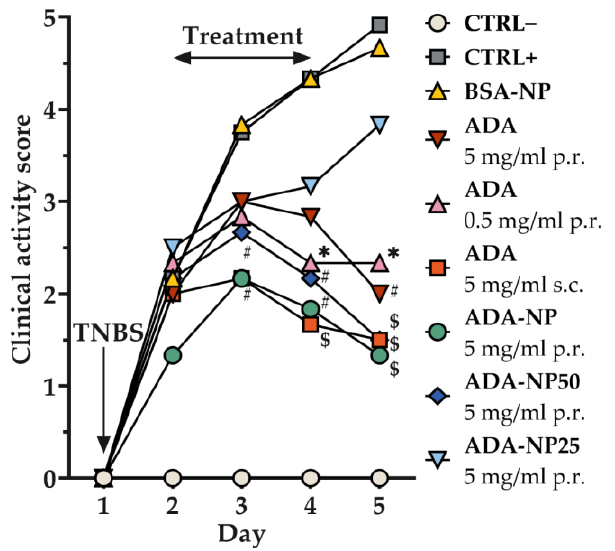
Figure 7. Therapeutic efficacy of adalimumab (ADA) treatment on clinical signs of colitis expressed as the clinical activity score, a composite measure of weight loss, stool consistency and rectal bleeding. Colitis was induced by rectal administration of TNBS (90 mg/kg body weight) and the mice were treated for 3 consecutive days. Data are shown as mean ± SD ( n = 6). Error bars are not shown for clarity reasons. Statistical significance was assessed by one-way ANOVA followed by Tukey’s multiple comparisons test (* p < 0.05, # p < 0.01, $ p < 0.001, vs. CTRL+). ADA-NP, ADA conjugated nanoparticles with 100% surface loading rate; ADA-NP50, ADA conjugated nanoparticles with 50% surface loading rate; ADA-NP25, ADA conjugated nanoparticles with 25% surface loading rate; BSA, bovine serum albumin; BSA-NP, BSA conjugated nanoparticles; CTRL − , healthy control, CTRL+, colitis